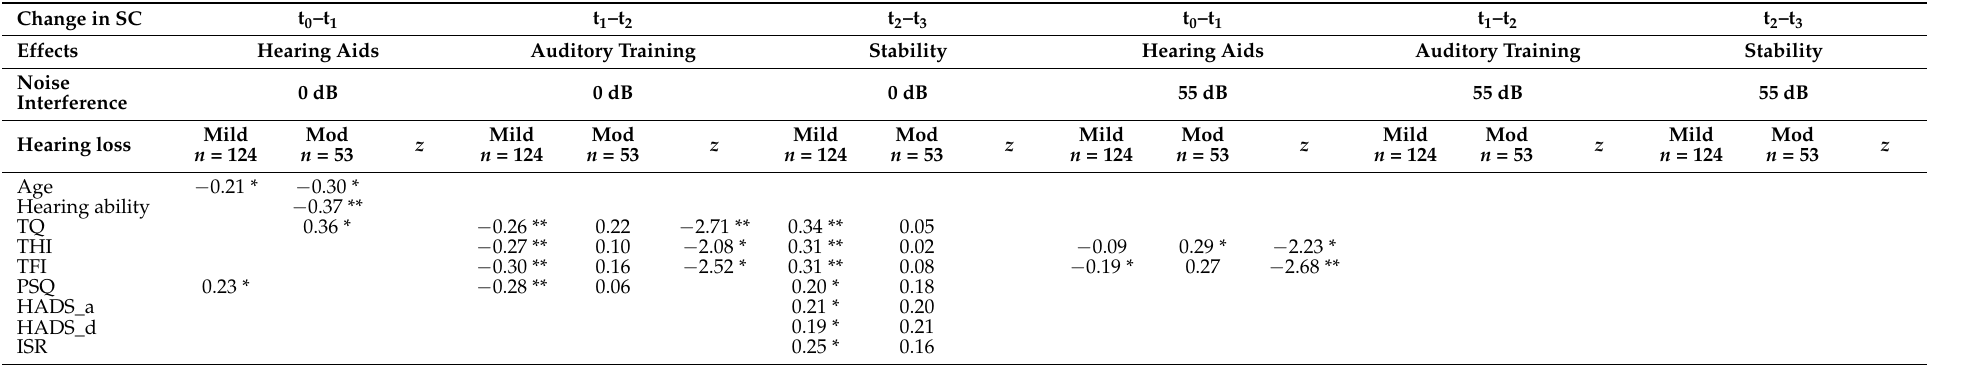
Table 4. Pearson’s r correlation coefficients for baseline values and change in SC across 0 dB and 55 dB noise interference conditions for patients